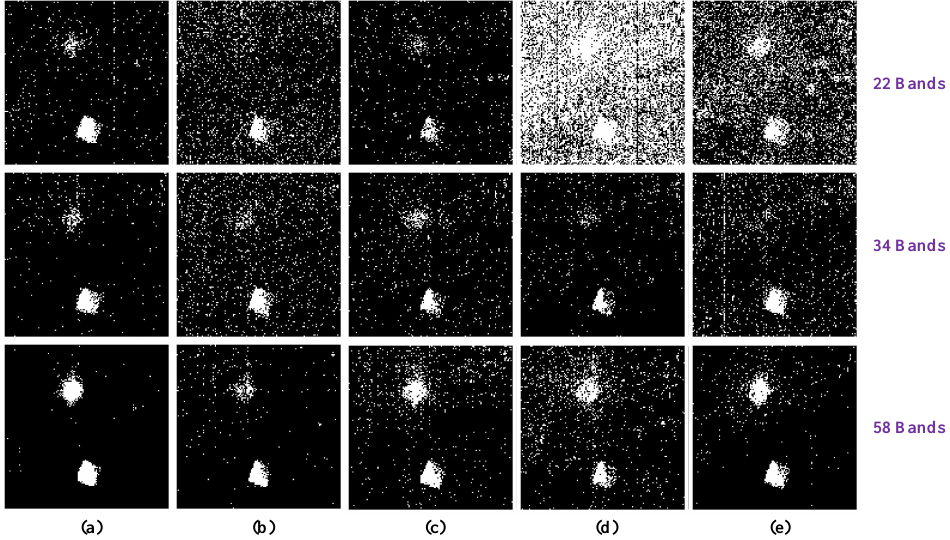
Figure 12. The detection maps of the Nano-Hyper dataset with different bands. ( a ) BBS, ( b ) LBS, ( c ) OCF, ( d ) ONR, ( e ) BCLA.